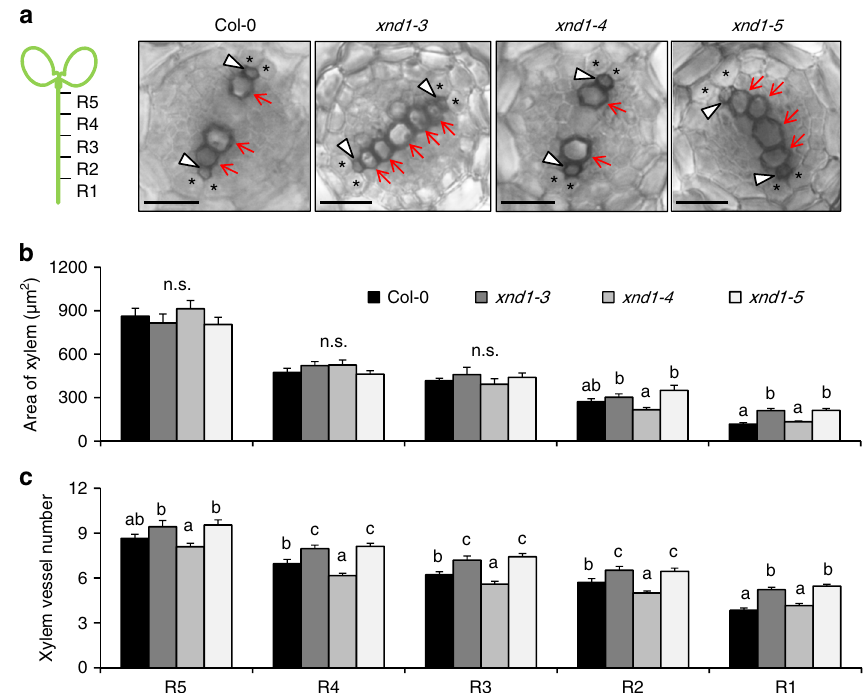
Fig. 5 XND1 negatively regulates root xylem formation. a The fi gure shows schematic representation of 2-cm-long segments (R1 – R5) used for characterization of xylem anatomy in the indicated genotypes and representative cross-sections within the R2 segment. Arrowheads and arrows indicate protoxylem and metaxylem, respectively. Asterisks indicate pericycle cells adjacent to xylem poles. Scale bars represent 20 µ m. b , c Xylem area ( b ) and vessel number ( c ) (mean values± SE) were measured in the indicated root segment and genotype, in 20 – 61 sections from 10 – 15 plants and 2 – 3 independent experiments. One-way ANOVA (Fisher ’ s LSD, P < 0.05) was used to test the signi fi cance of the data (n.s. = not signi fi